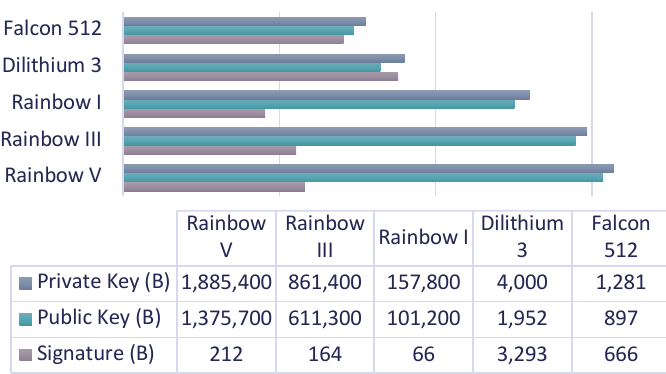
Figure 2. Memory usage of post-quantum signature